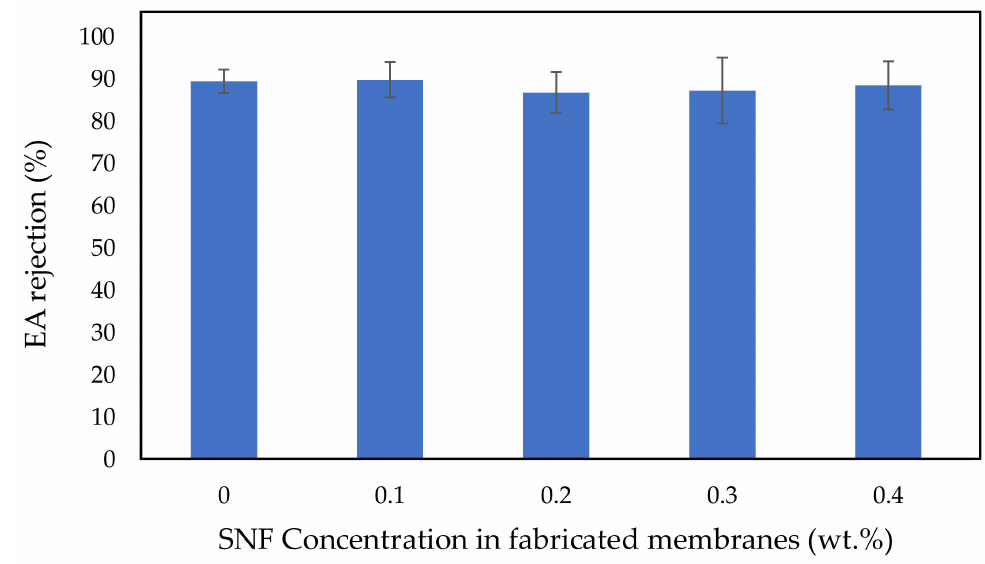
Figure 7. Effect of SNF concentration on EA rejection.